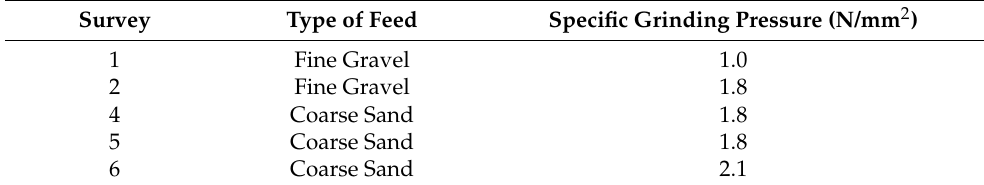
Table 2. Summary of surveys carried out at Itaquareia HRC™ circuit.